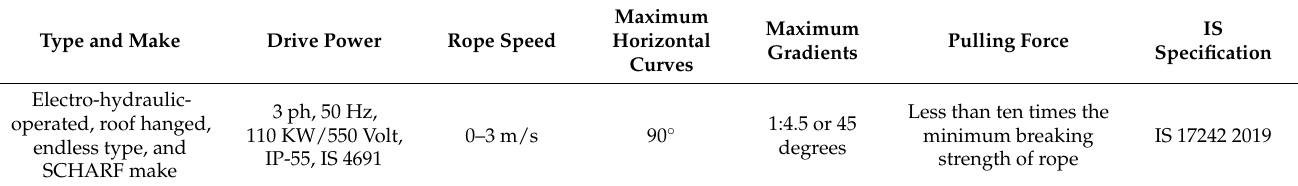
Figure 2. Basic arrangement of MRCL.